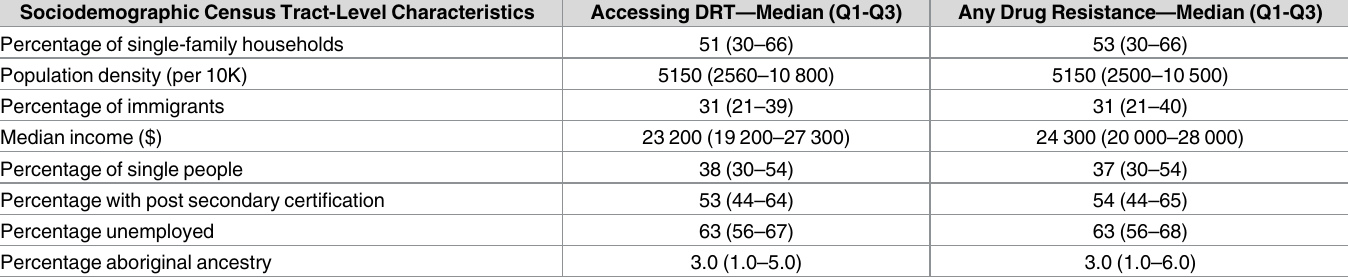
Table 2. Sociodemographic census tract-level characteristics of accessto drug resistance testing cohort and development of drug resistance cohort. Sociodemographic Census Tract-Level